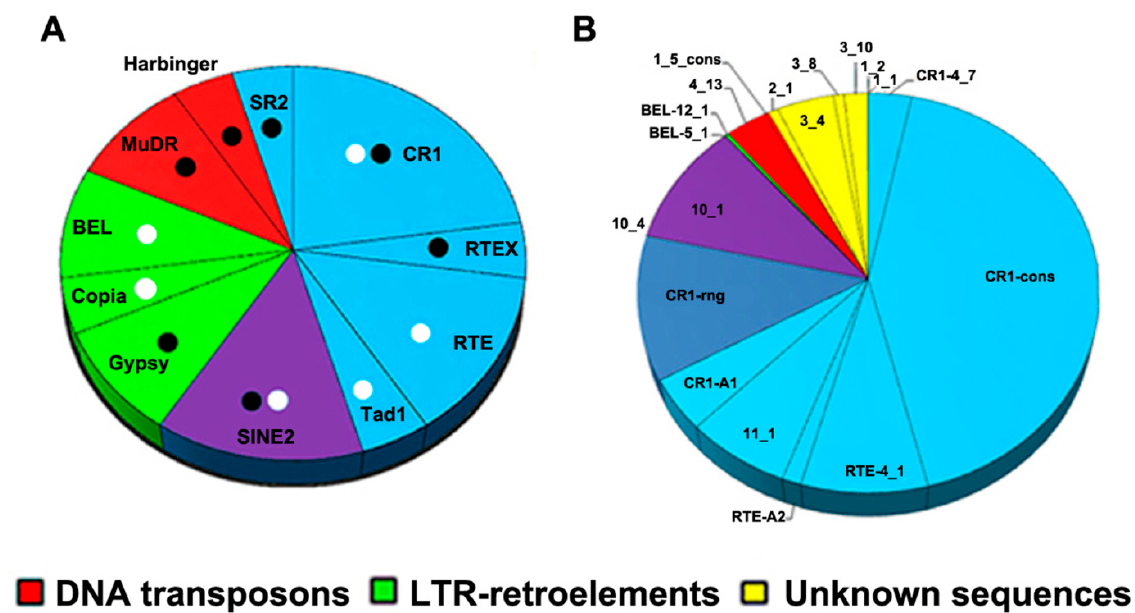
Figure 4. Distribution of TE families among SAFLP cloned bands from H. elongata ( A ), and TPM (transcripts per million) values for transcripts corresponding to cloned fragments ( B ). Similar sequences were merged into consensus sequences where possible (CR1-cons is constructed from CR1-B1, CR1-B2, and CR1-B3; 1_5_cons is composed of 1_5 and 2_5 fragments). Black dots indicate the sequences cloned from conserved SAFLP bands, and white dots indicate those from variable bands. Red—DNA TEs; green—LTR elements; light blue—LINEs (RTs containing LINE-like fragments); dark blue—LINE-like fragments containing CR1-rng; violet—SINE; yellow—non-annotated sequences.